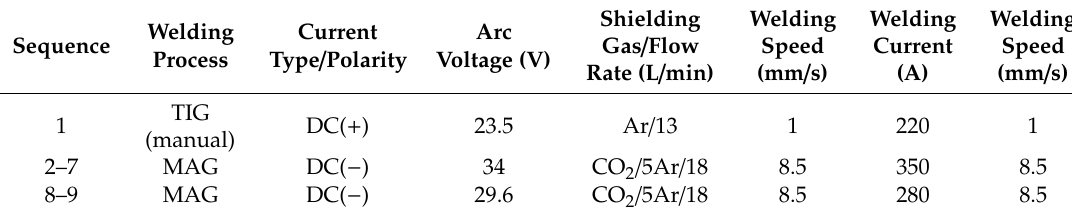
Figure 12. The sampling method and the weld procedure.